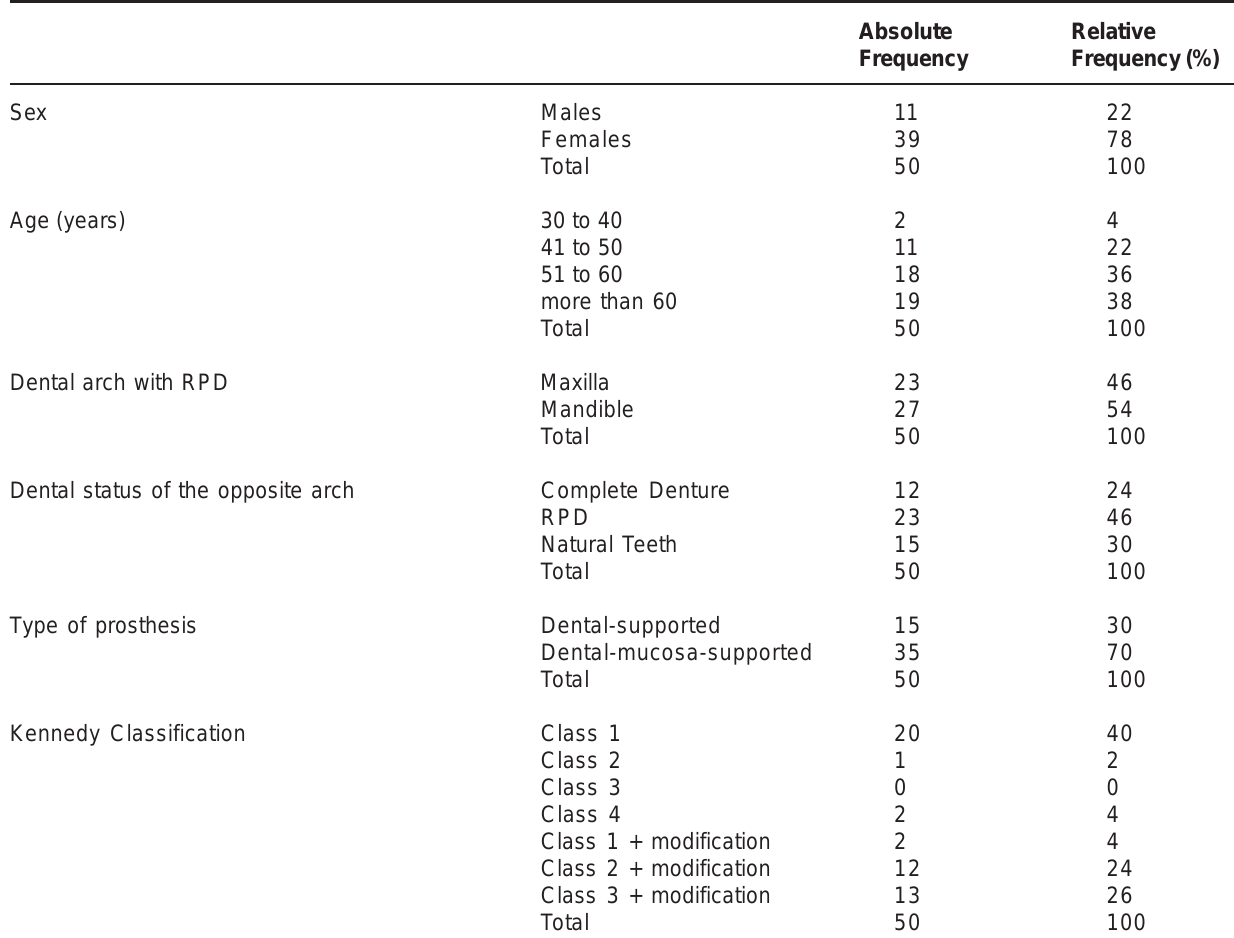
TABLE 1- Demographic and clinical characteristics of the sample (n=50)